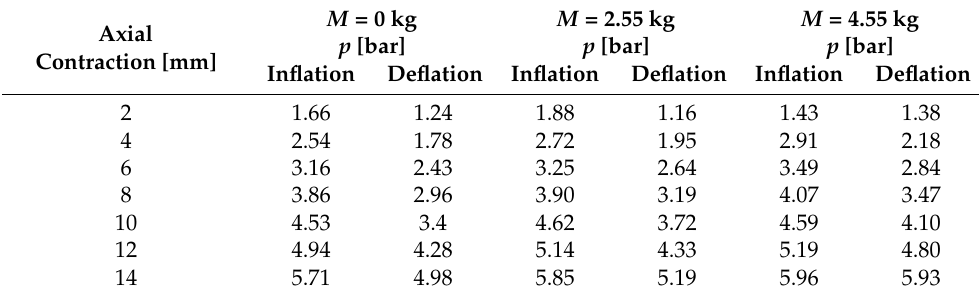
Table 6. Supply pressure values necessary for axial contraction of the muscle.